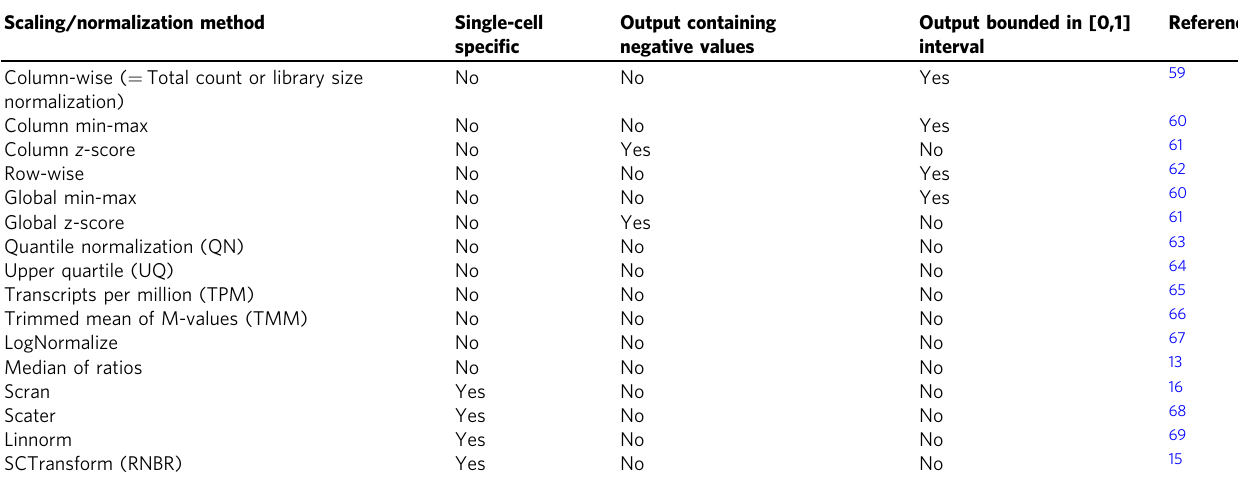
Table 3 Detailed description of different scaling/normalization approaches used in the